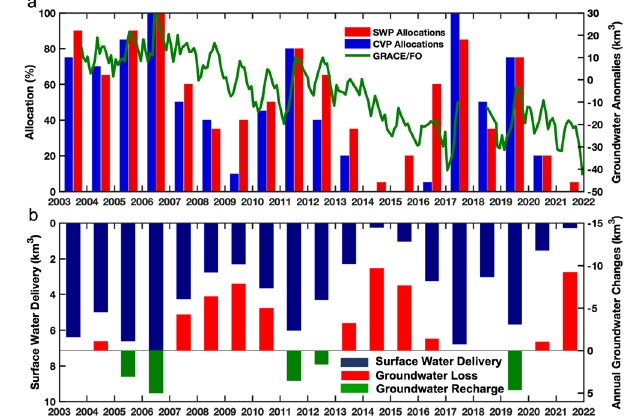
Fig. 5 | Groundwater and surface water management in Central Valley. a Comparison between annual surface water allocations in the aqueducts of the California State Water Project (SWP) and the federal Central Valley Water Project (CVP) and GRACE/FO-derived groundwater storage anomalies. b Comparison between annual surface water deliveries (dark blue bars) of SWP and CVP to the GRACE/FO derived groundwater changes (red and green bars) in Central Valley. The groundwater changes in 2003, 2017, and 2018 are not included because GRACE/FO-derived data do not have complete coverage over the